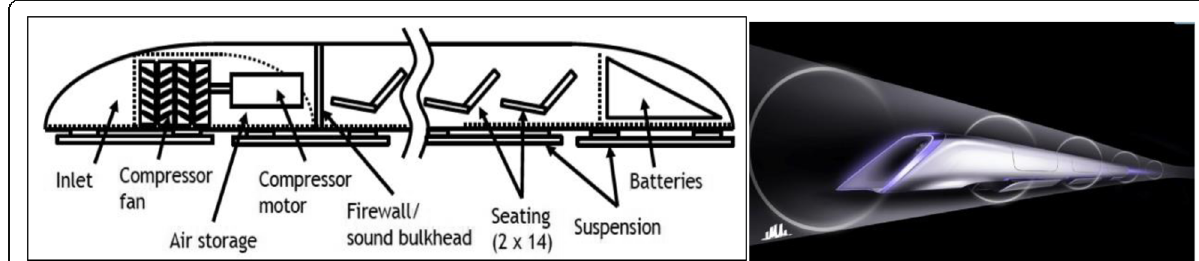
Fig. 4 Conceptual design and subsystems of the HL system (source: